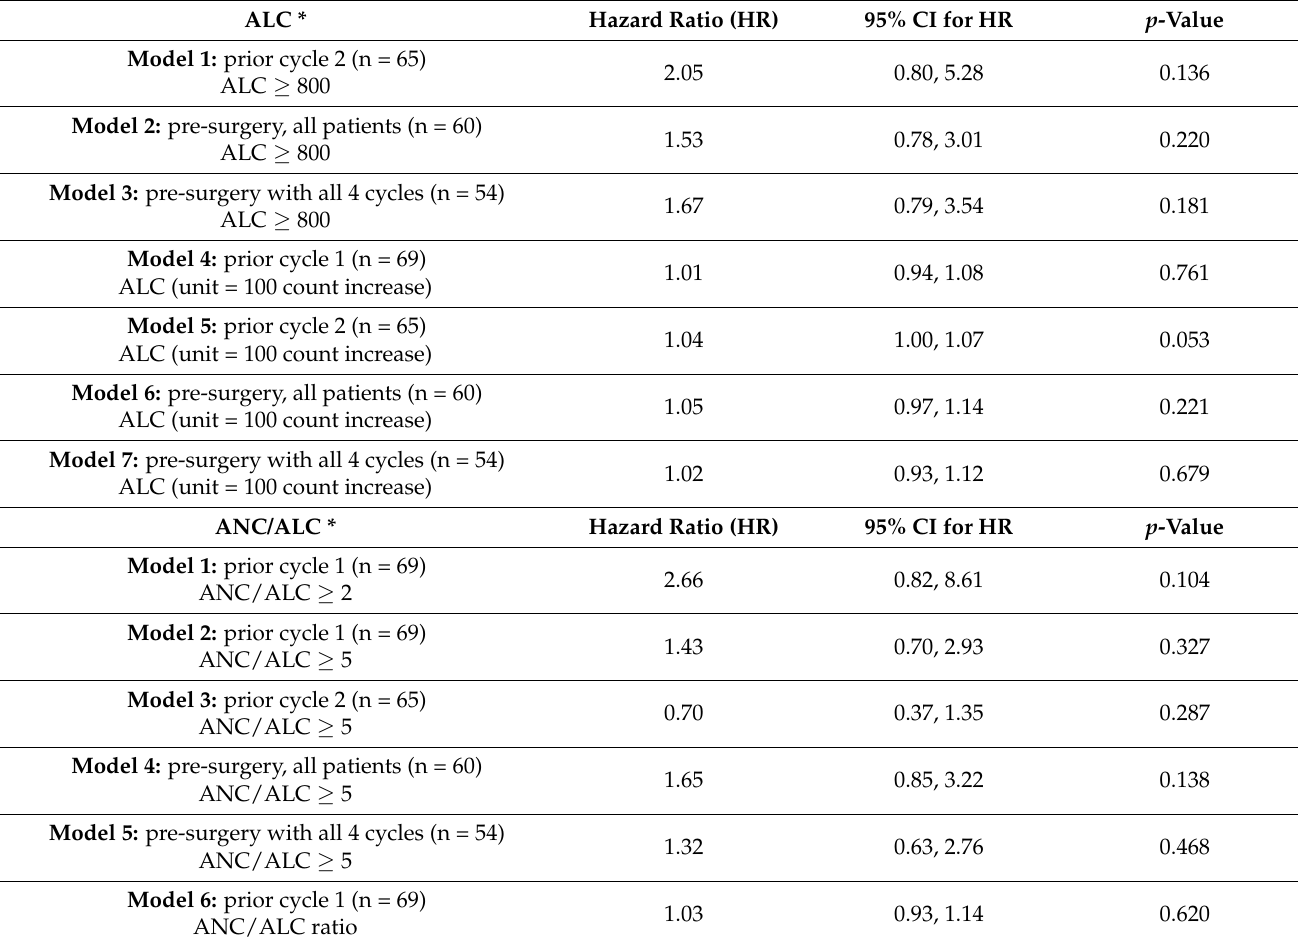
Table 2. Survival analysis of PFS by various cell count cutoff values at different times using Cox proportional hazard